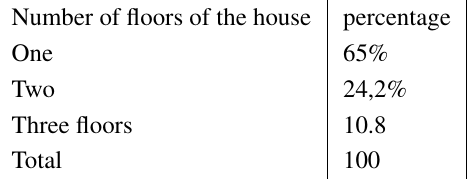
Table 2. The number of floors that make up the